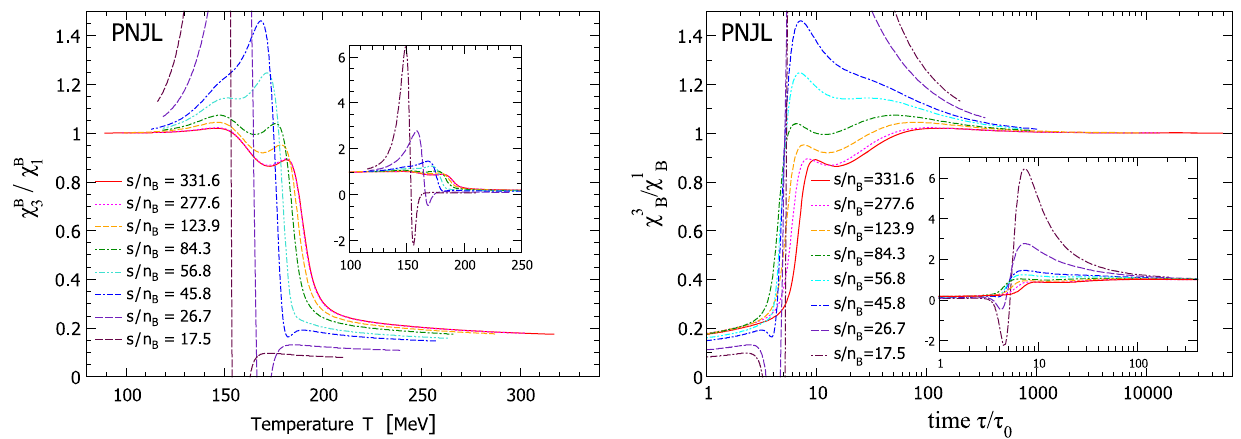
Fig. 8 PNJL results for the normalized skewness of the baryon-number distribution plotted as a function of temperature (left panel) and time τ (right panel) along the isentropic trajectories shown in Fig. 1. The evolution always starts at time τ 0 = 1 fm/c, corresponding to the entropy densities s 0 given in Table 4